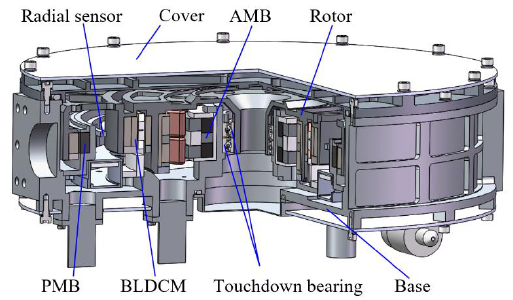
Figure 1. Structure of the MLRW.